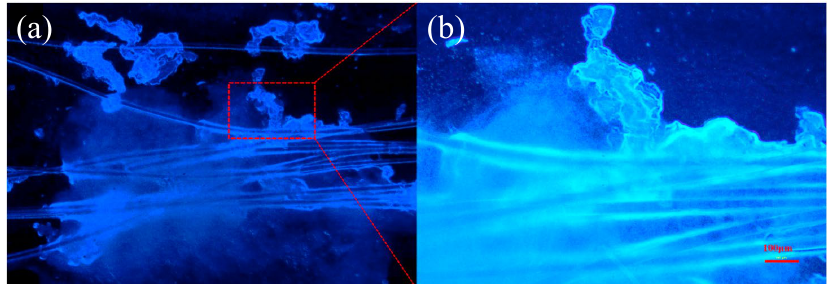
Figure 4. The optical microscope images of deposit on PP fiber [62]: ( a ) deposit induced by EPS; ( b ) biological organic film on PP fiber surface and deposits surface.